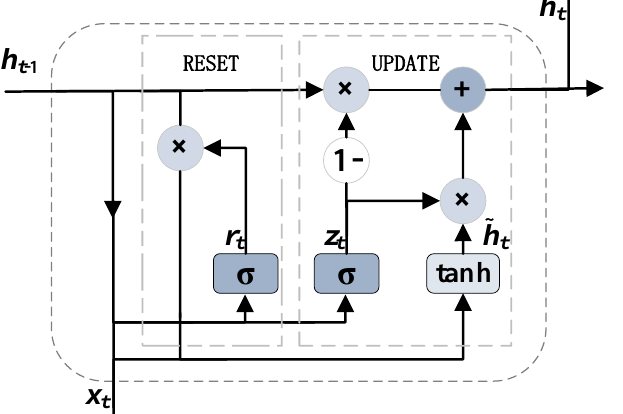
Figure 4. Gated recurrent unit.